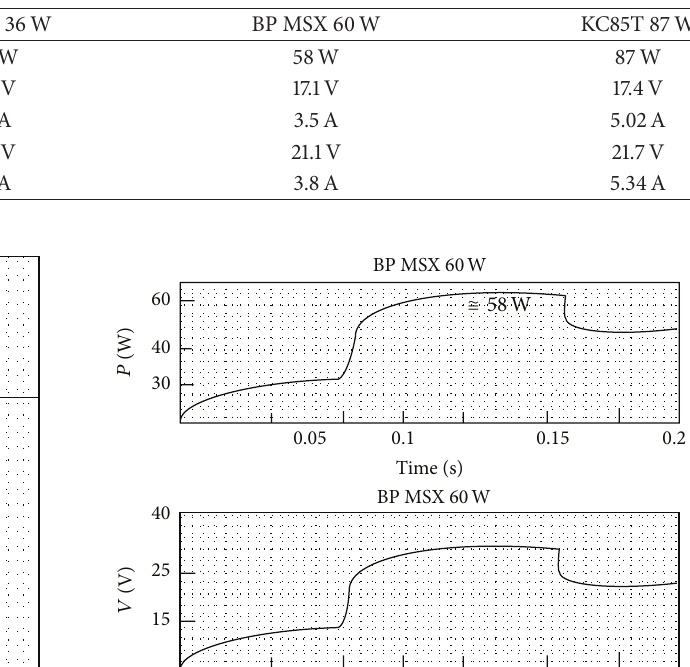
Table 3: Standard test condition (STC) specification of the PV modules.